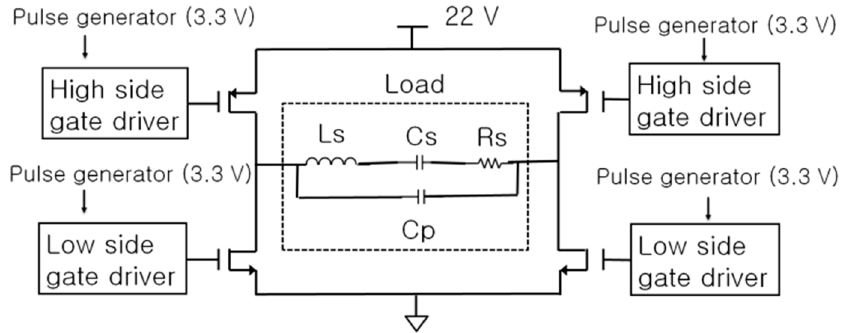
Figure 1. Schematic of full bridge class DE power amplifiers. When a thick gate oxide is used in the power amplifier, a gate swing of 20 V is required for the low-side gate driver. Similarly, mid and thin gate oxides require gate voltage